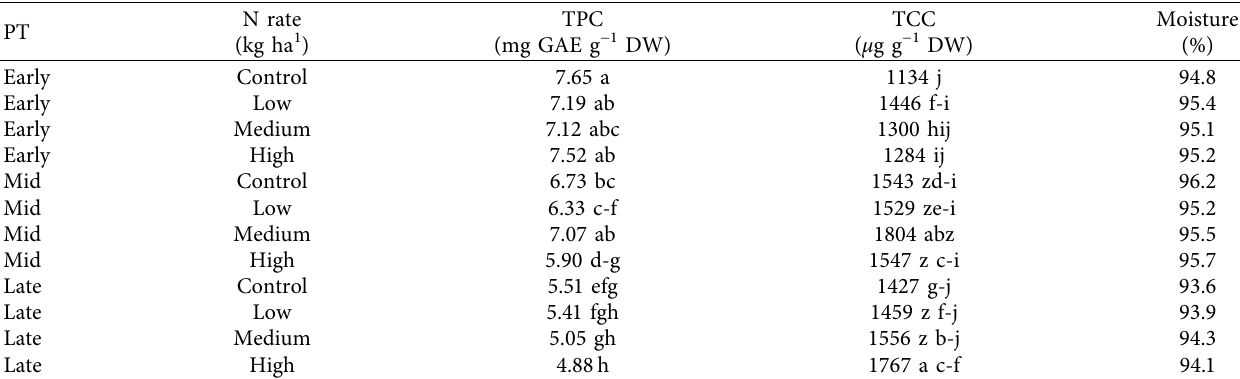
Table 6: Interaction effect of planting time (PT) and nitrogen (N) rate on total phenolic content (TPC) and total carotenoid content (TCC). PT